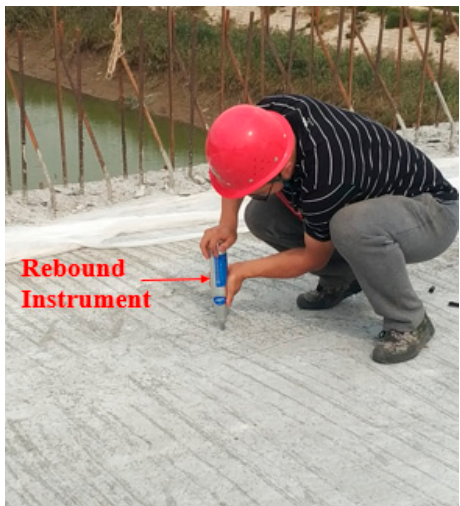
Figure 5. Test of the concrete strength by rebound instrument.